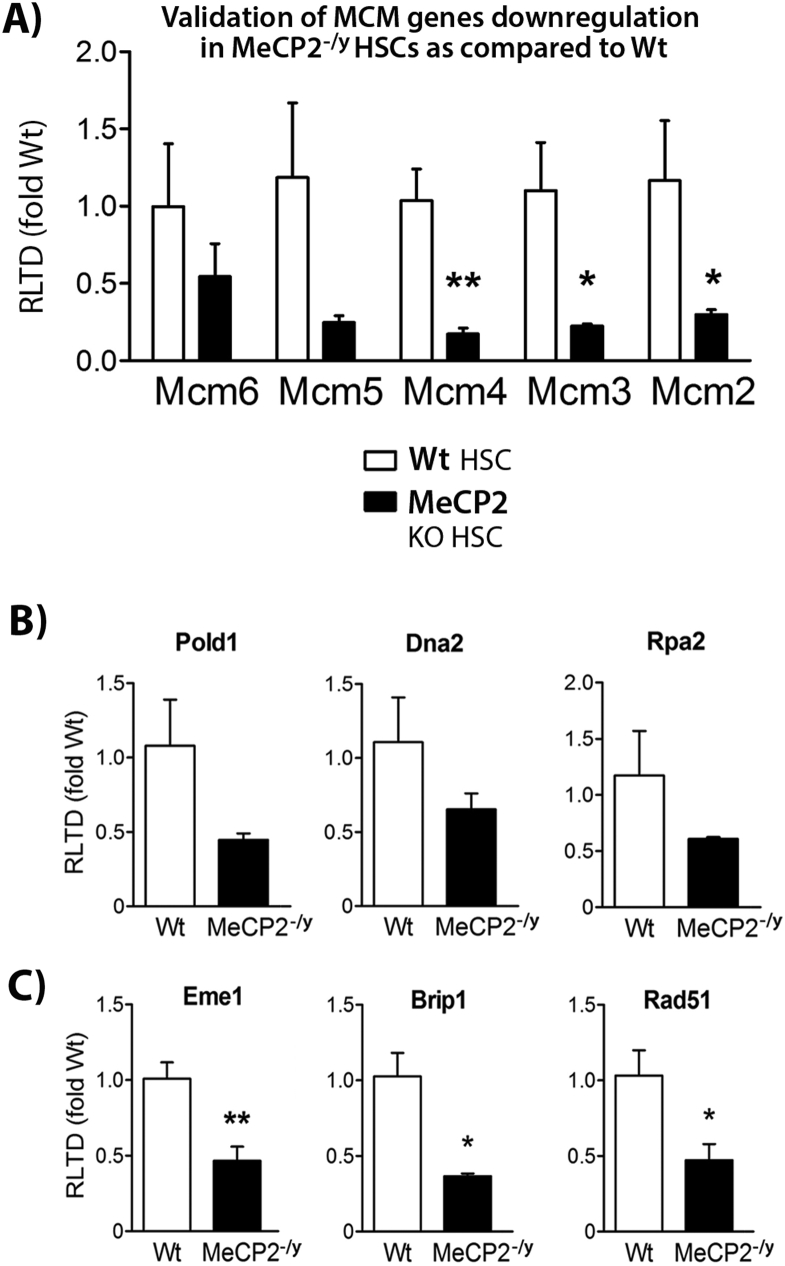
(A) mRNA level of Mcm6-2 quantified by qRT-PCR to validate the results of microarray. (B, C) mRNA levels of Pold1, Dna2, Rpa2, Eme1, Brip1, and Rad51 quantified by qRT-PCR to validate the results of microarray. Error bars in relevant panels represent mean ± SEM. Statistical significance was determined by Student t test; *P < .05, **P < .01. KO, knockout; RLTD, relative level of transcriptional difference.